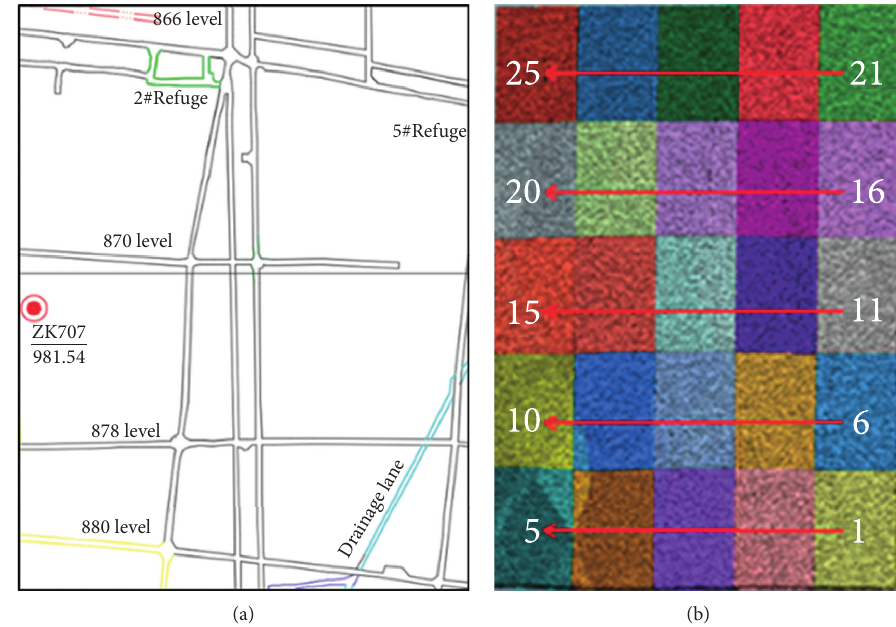
Figure 2: Optimization calculation model of mining sequence. (a) Geological map. (b) Block